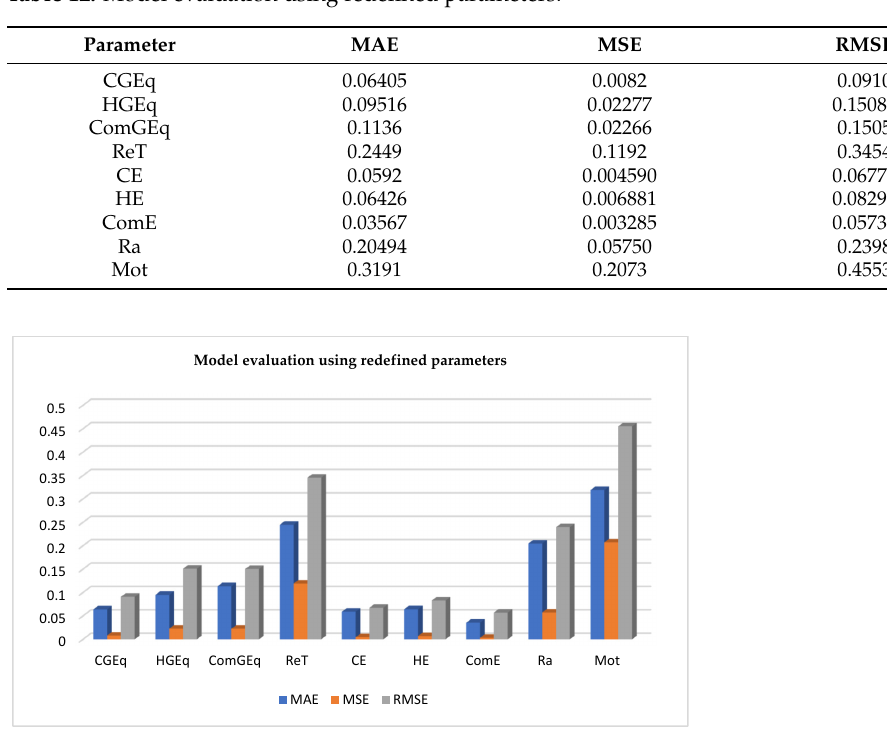
Table 12. Model evaluation using redefined parameters.